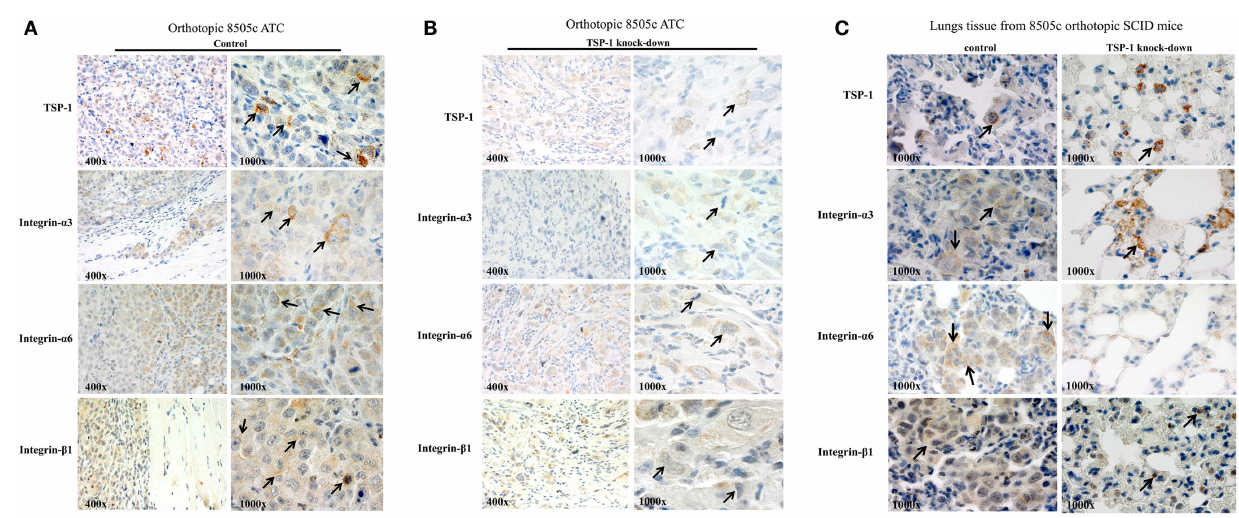
FIGURE 4 |TSP-1, ITG α 3, ITG α 6, and ITG β 1 immunoexpression in the orthotopic 8505c human anaplastic thyroid cancer (ATC) (A) without TSP-1 knock-down (control, arrows highlight protein immunoexpression in the 8505cATC cells in vivo ) or withTSP-1 knock-down (arrows highlight protein immunoexpression in the 8505cATC cells in vivo ) and (B) withTSP-1 knock-down (control, arrows highlight protein immunoexpression in the 8505cATC cells in vivo ) . (C) Orthotopic 8505c metastatic ATC cells in the lungs of SCID